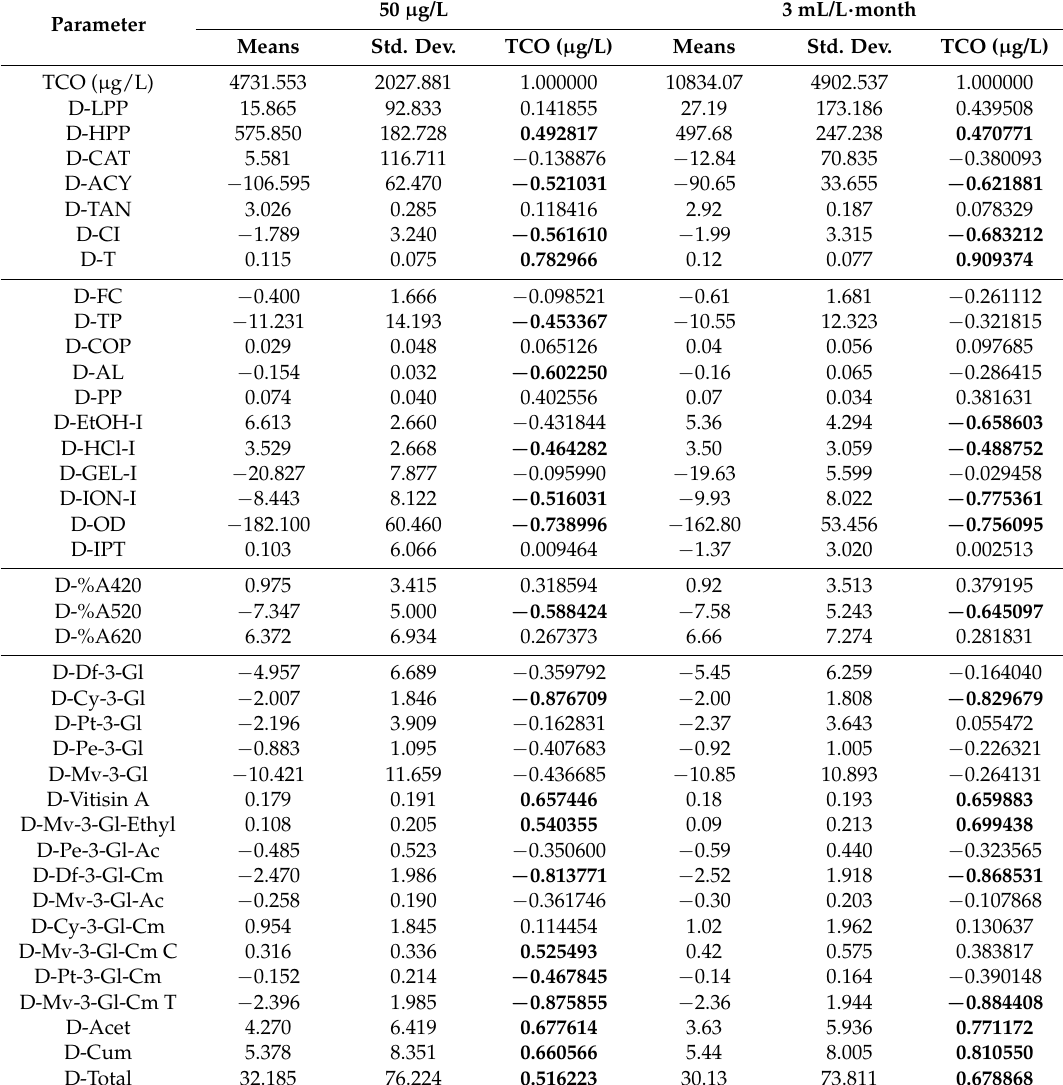
Mean and standard deviation of each delta analyzed parameter, and correlation coefficients between parameters and oxygen consumed by wine in each micro-oxygenation and wood strategies